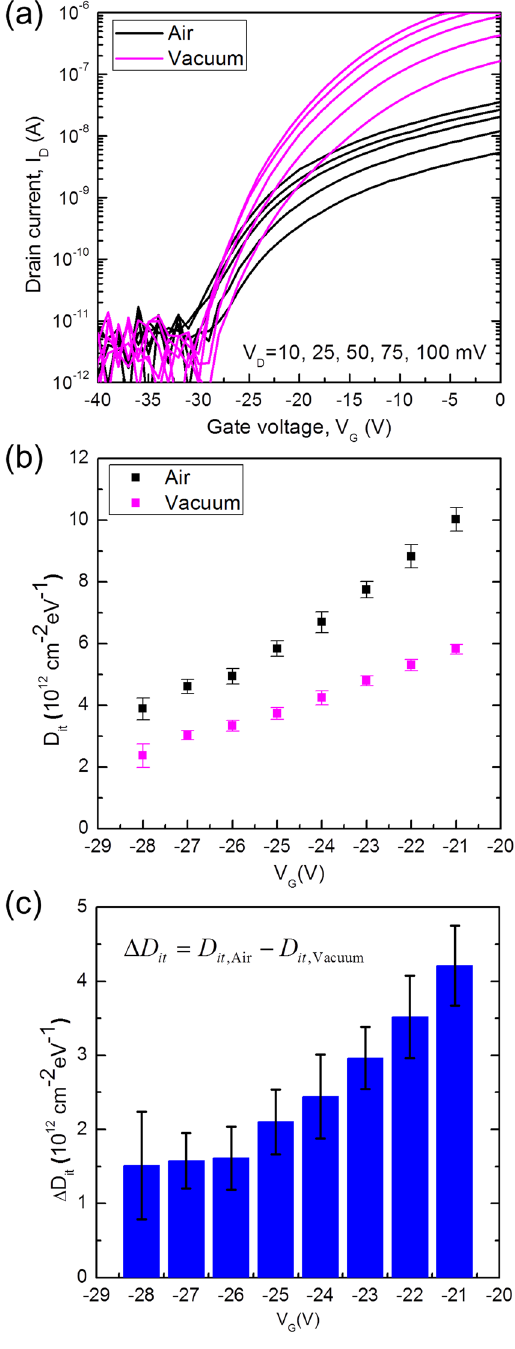
Figure 3. Extraction of interface traps density under different ambient conditions. ( a ) Measurement of the drain current ( I D ) as a function of gate voltage ( V G ) with different values of the drain voltage ( V D ) to extract the energy distribution of interface traps that can explain the data. The drain voltage is modulated with the values of 10, 25, 50, 75 and 100 mV. The same device is measured under two ambient conditions of “Air” for atmospheric pressure and “Vacuum” for vacuum condition (4.0 × 10 − 8 Torr) after vacuum annealing (400 K for ~14 hr). ( b ) Extracted interface trap density for the two ambient conditions using a subthreshold slope method, described in Methods. ( c ) Difference of the interface trap density between the two ambient conditions ( Δ D it = D it , Air − D it , Vacuum , where D it , Air and D it , Vacuum are the interface trap densities under atmospheric pressure and vacuum condition (4.0 × 10 − 8 Torr) after vacuum annealing (400 K for ~14 hr),